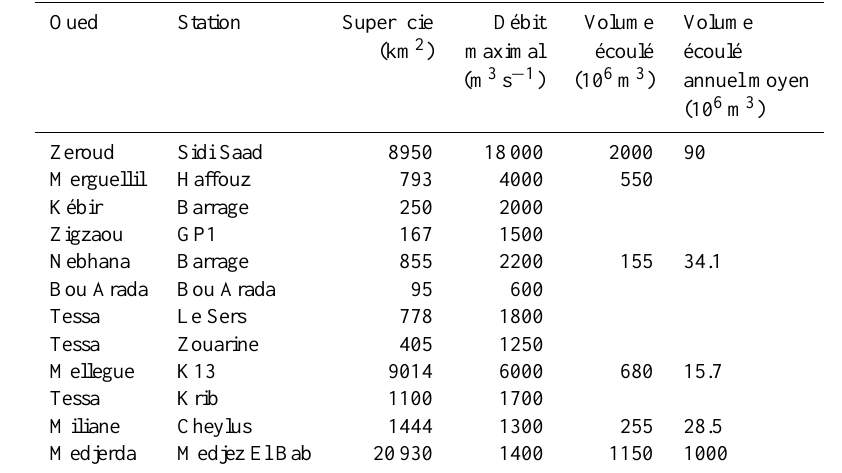
Tableau 1. Caractérisation des débits de pointe et écoulements cumulés lors des événements de crues de l’automne 1969 dans les oueds principaux (Pias, 1970).